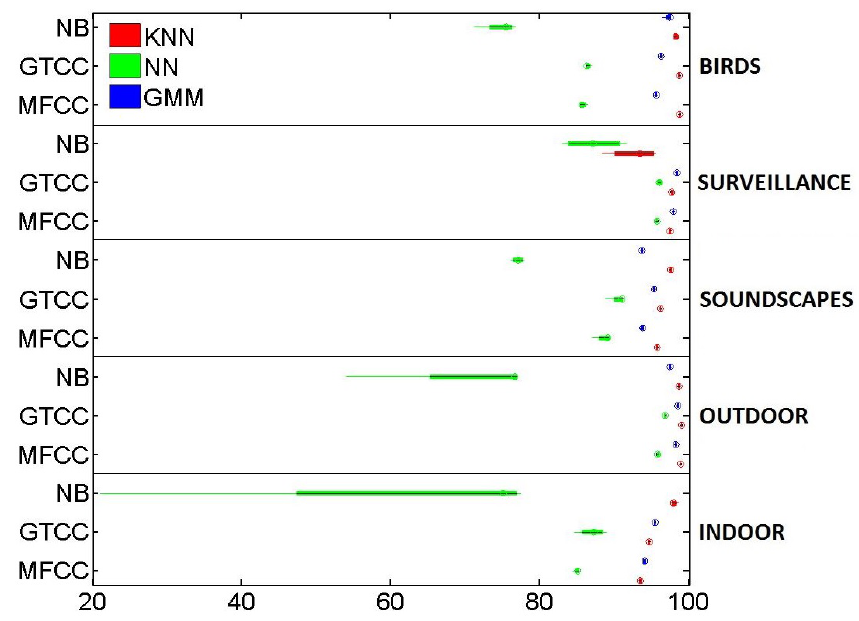
Figure 4. Boxplot of the Recall’s Mean and Variance in the 4-fold